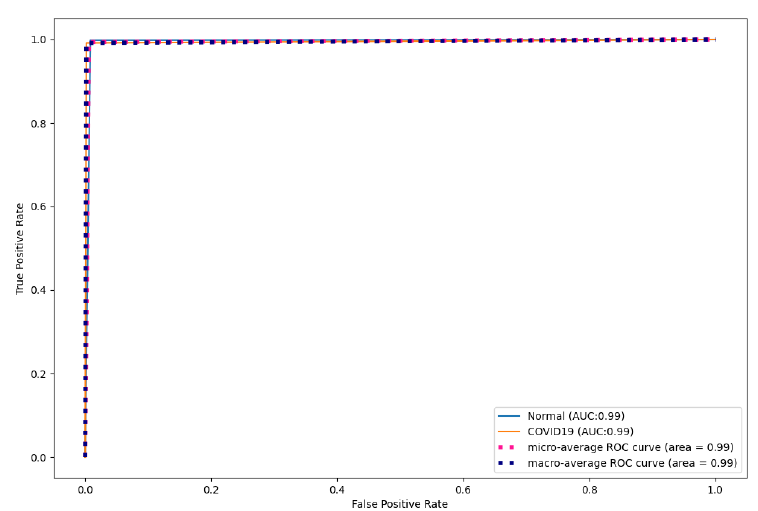
Figure 9. CNN ROC curves for CT images.